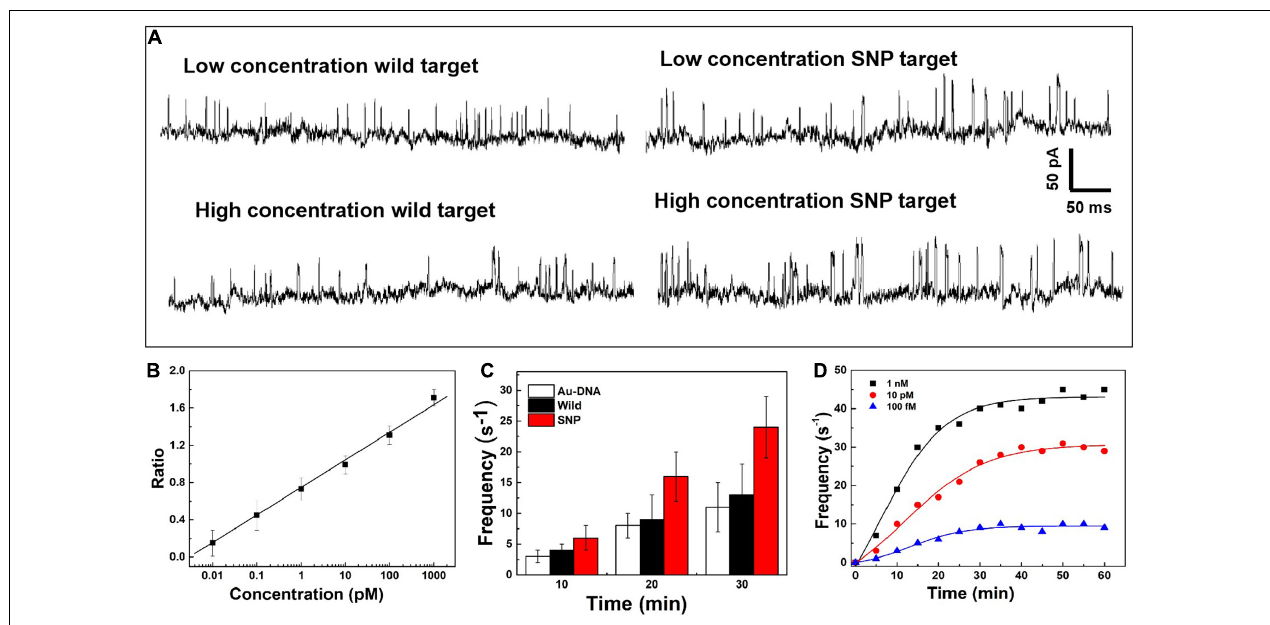
FIGURE 3 | (A) Current signals in the presence of the SNP target and wild target at low and high concentrations. (B) Log plot of the capture ratio of the dimer and monomer obtained from blockage current versus SNP concentrations. (C) Signal frequency versus experimental time. (D) The capture frequency of blocking events dependent on time at different